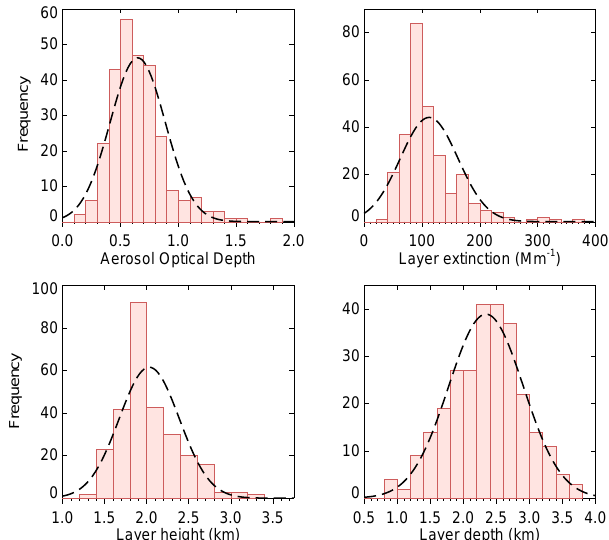
Figure 7. Distributions of aircraft lidar observations of AOD, layer extinction, layer height and layer depth, for the whole data set con- sidered in this paper (276 vertical profiles). A Gaussian curve with the mean and standard deviation of the data set is superimposed (dashed